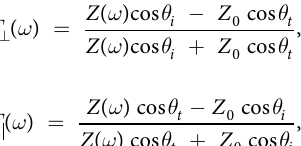
where θ i and θ t are the incident and transmission angles, respectively. Although the MM absorber shows per- fect absorptivity under normal incidence, its absorptivity changes when the incident angles are varied as per Equations (2),(5) and (6). Therefore, an angle-insensitive unit cell must be designed for obtaining an incidence angle-insensitive MM absorber. In addition, the transmission coefficient can be minimized by increasing the loss factor. The refractive index (n) of an MM has a particularly large imaginary part, which corresponds to the loss factor. A transmitted wave is dissipated by a large loss factor in a substrate.